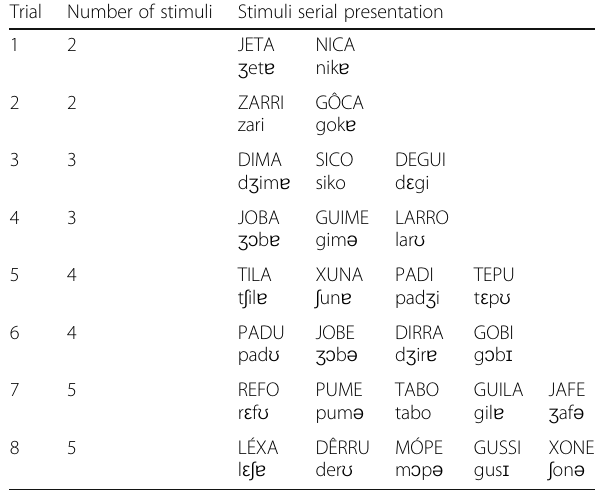
Table 3 The disyllabic pseudowords used in each one of the